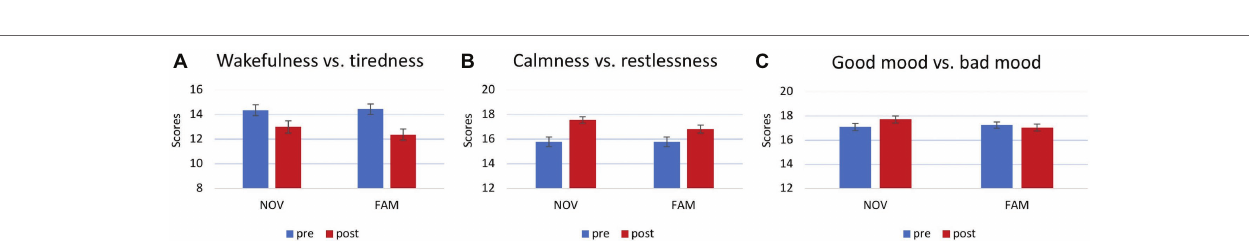
FIGURE 4 | Main effect of movie rating. Participants of the NOV group (mean 52.51%) rated movies more positive than participants in the FAM group (mean 33.52%). Error bars reflect ±1